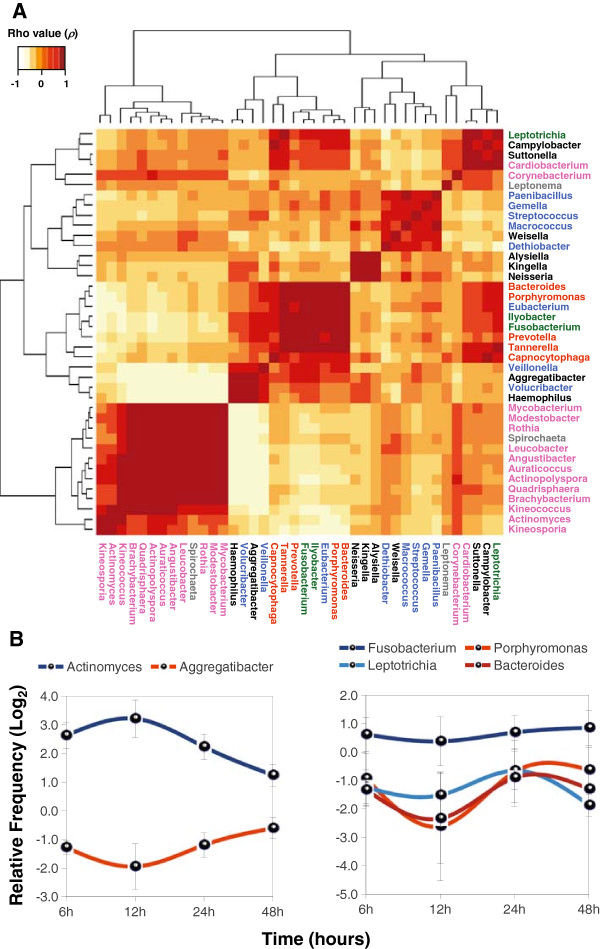
Positive and negative interactions in the oral biofilm active microbiota. A – Relative abundance of bacterial genera (based on 16S assignment, see Methods) and fluctuation through time were studied in a pairwise manner calculating the Spearman’s rho parameter (see Methods). Genera labels are highlighted in color according to phylum: Actinobacteria (pink), Bacteroidetes (Orange), Fusobacteria (Green), Firmicutes (Blue), Proteobacteria (Black), and Spirochaetes (Grey). B – Detail of the Spearman correlations found in the analysis. The left panel shows a strong negative (ρ ~ - 0.75) correlation between Actinomyces and Aggregatibacter through time. In the right panel, a positive correlations is presented among late colonizers such as Leptotrichia, Fusobacterium, Porphyromonas, and Bacteroides (ρ ~ 0.80).